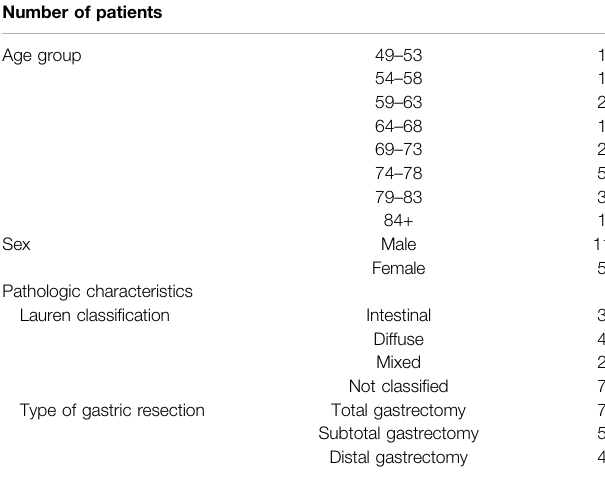
TABLE 1 | Demographic and clinical parameters of gastric cancer patients.